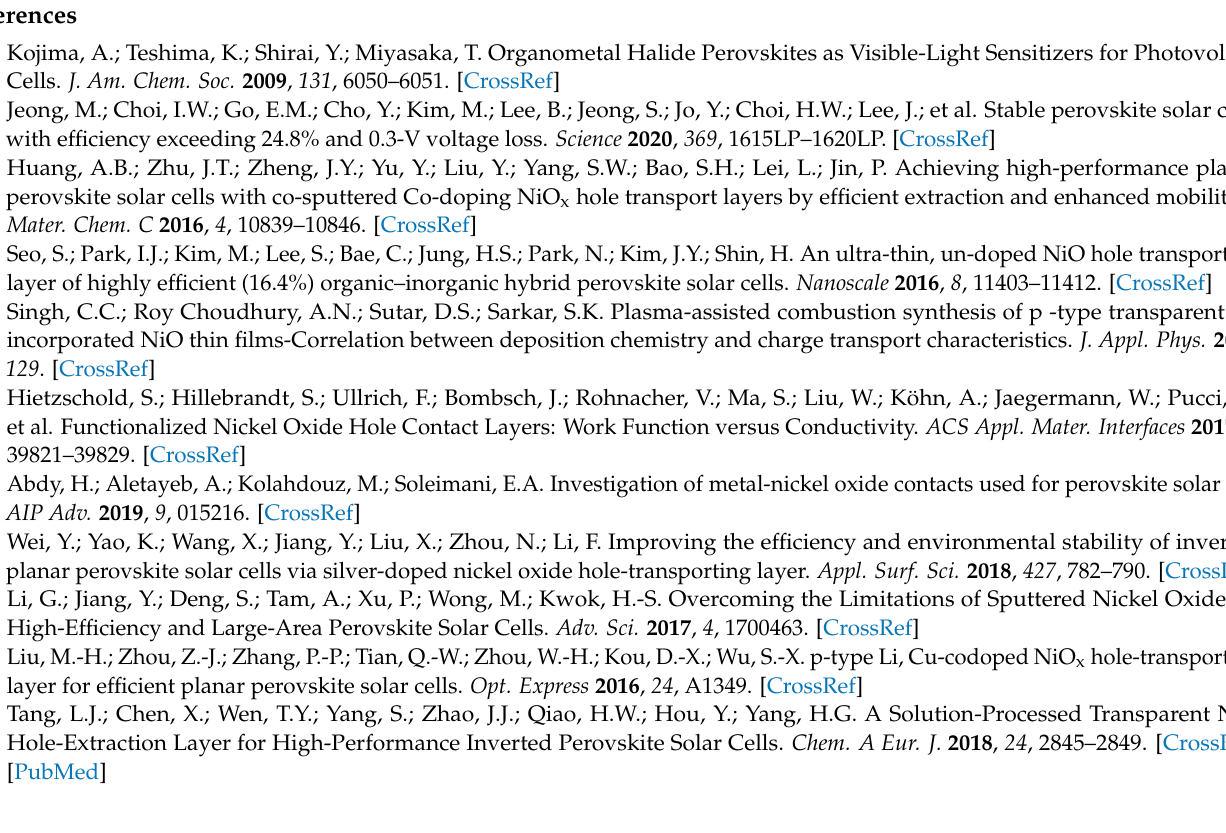
atomic ratios for the Cu:NiO x films fabricated form precursor containing 0.1 Acac and annealed at 200 and 300 ◦ C; Figure S2: contact angle picture of water on films prepared using precursor containing w/o, 0.1, and 1.5 molar ratio of fuel (Acac) to oxidizer (Cu, Ni nitrates) annealed at 150, 170, and 200 ◦ C; Figure S3: contact angle picture of water on films prepared using precursor 0.1 molar ratio